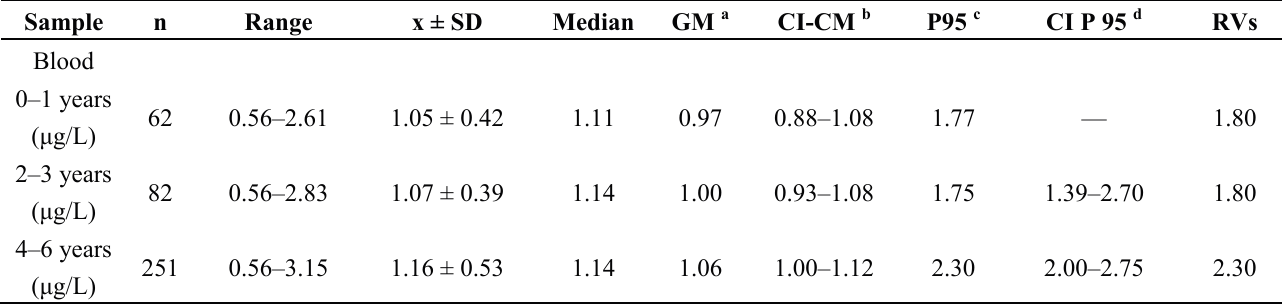
Table 2. Comparison of mercury concentrations in blood, urine, and hair of children aged 0 to 6